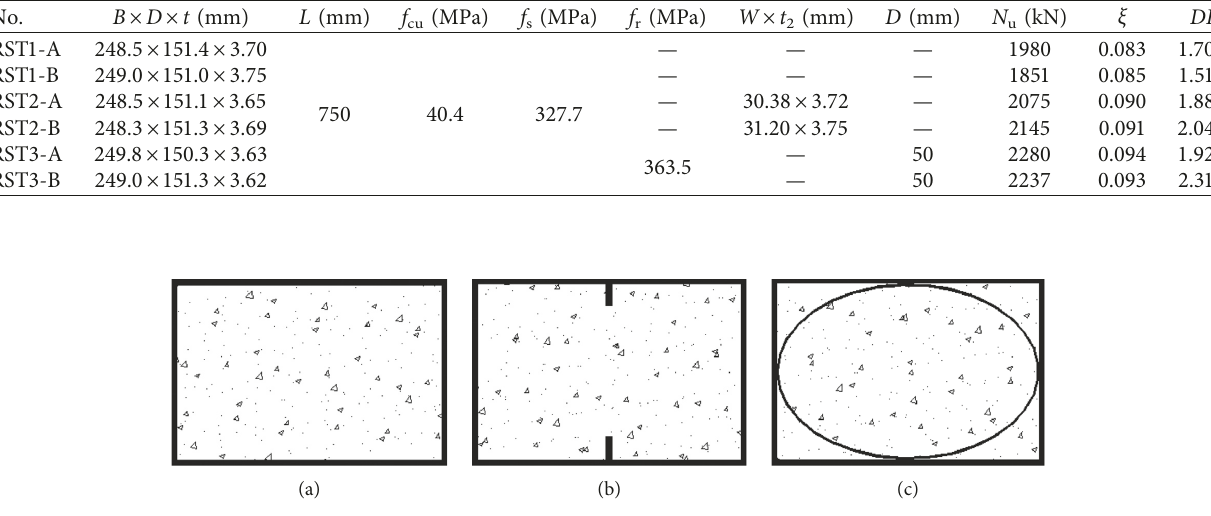
Figure 1: Cross sections of specimens. (a) Specimens without confinement (RST1), (b) specimens with stiffening rib (RST2), and (c) specimens with stirrups (RST3). Table 2: Concrete proportioning design.